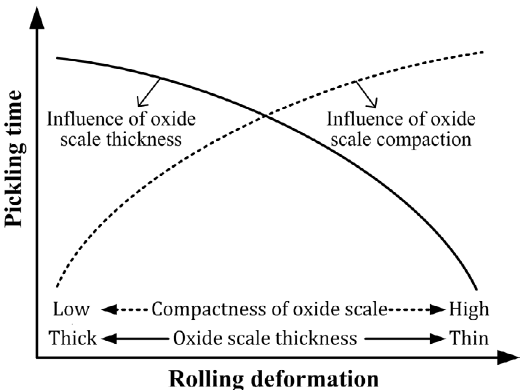
Figure 7. Schematic diagram of the effects of rolling deformation on the pickling time.